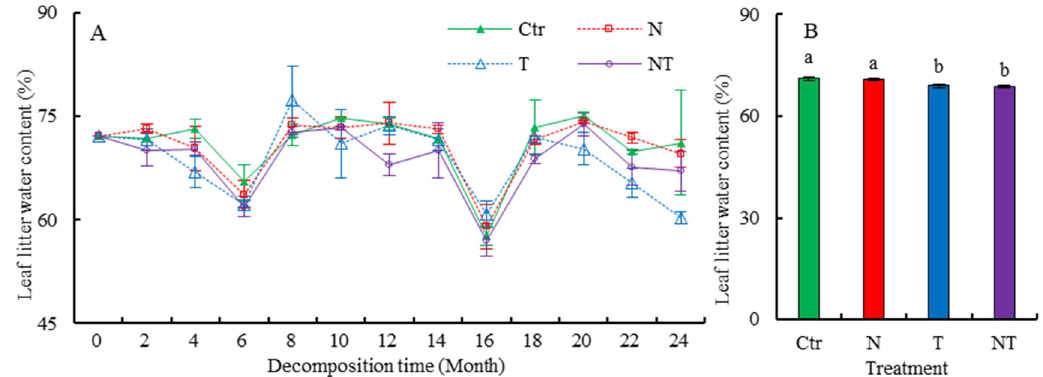
Figure A2. Changes in leaf litter water content exposed in the field during the two-year experiment ( A ). Different lowercase letters in panel ( B ) denote significant differences between treatments based on the linear mixed effects models (multiple comparisons with Bonferroni adjustment method, p < 0.05). Error bars represent the standard deviations of the means ( n = 36). Abbreviations of treatments are given in Figure A1.